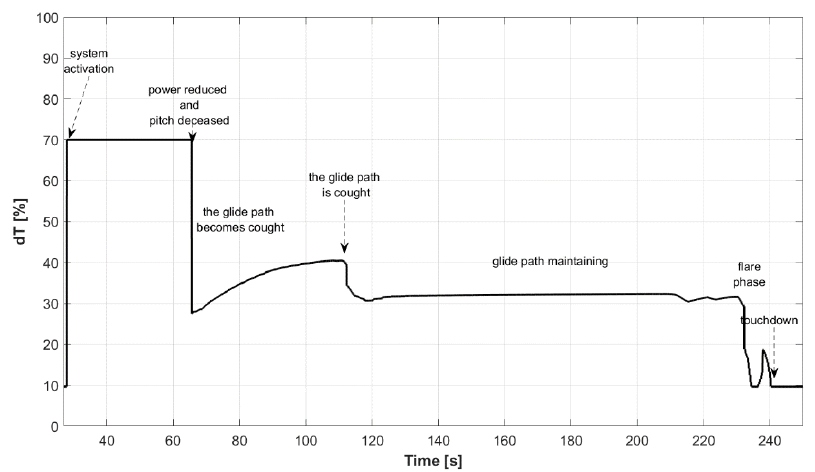
Figure 21. Engine power control signal—throttle position δ T